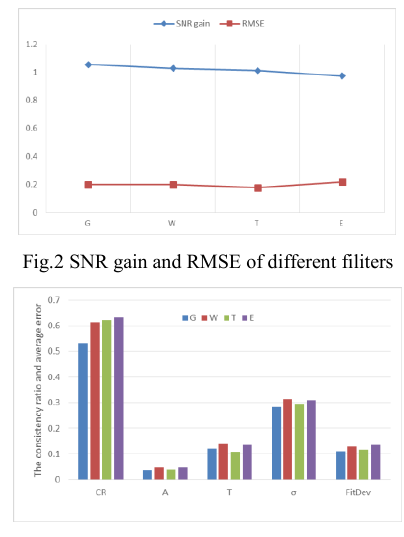
Fig.3 Fitting effect comparartion of different